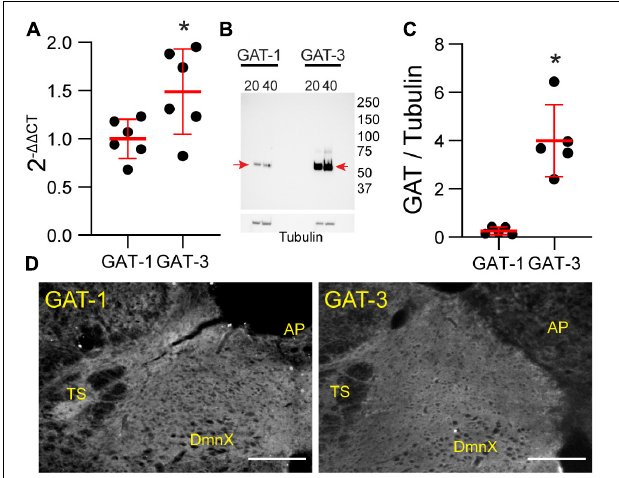
FIGURE 1 | Gamma-aminobutyric acid transporters 1 and 3 are expressed in the nTS. (A) Quantification of mRNA transcript of GAT-1 and GAT-3 in the nTS. GAT-3 mRNA transcript was greater than in GAT-1 ( N = 6, * p ≤ 0.05 paired t -test). (B) Immunoblot example GAT-1 and 3 in the nTS [ left , GAT-1 (20 and 40 µ g) and right , GAT-3 (20 and 40 µ g)]. Note the GAT-1 band at ∼ 67 and the GAT-3 band at ∼ 70 kDa. Tubulin was used as a control. (C) Quantification of the GAT-1/tubulin ratio ( left ) and GAT-3/tubulin ratio ( right ). GAT-3 is found in higher quantities in the nTS than GAT-1. N = 5, * p ≤ 0.05 paired t -test. (D) IHC of GAT-1 and GAT-3 in nTS. TS, solitary tract; DmnX, dorsal motor nucleus of the vagus, AP, area postrema. Scale, 200 µ m.